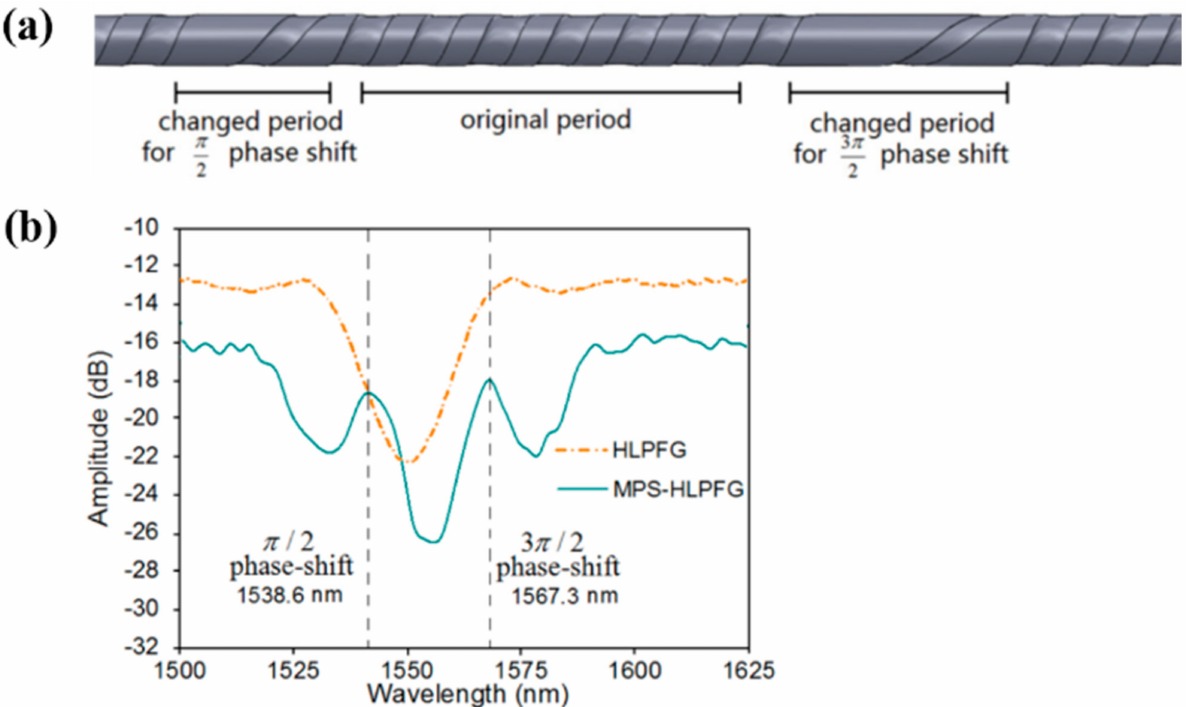
Figure 32. ( a ) Schematic diagram and ( b ) transmission spectra of the proposed PS-HLPG. Adapted with permission from ref. [160]. © The Optical